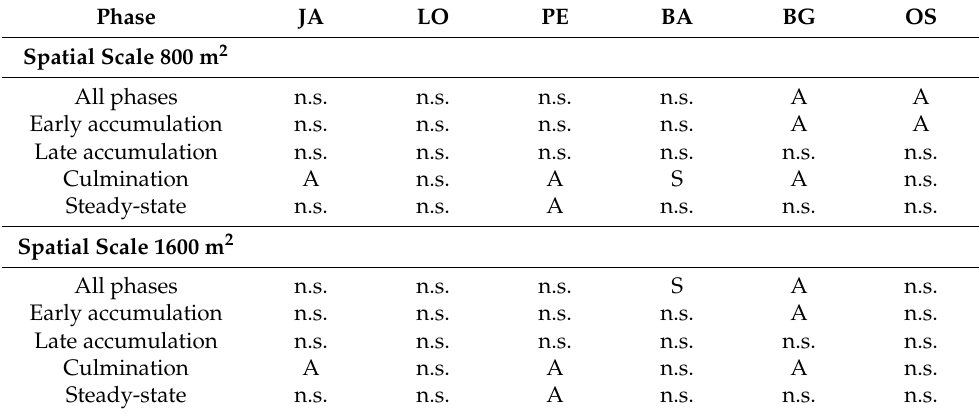
Table 3. Results of testing for the spatial independence of the phase distribution in four (800 m 2 ) and eight (1600 m 2 ) nearest-neighbor